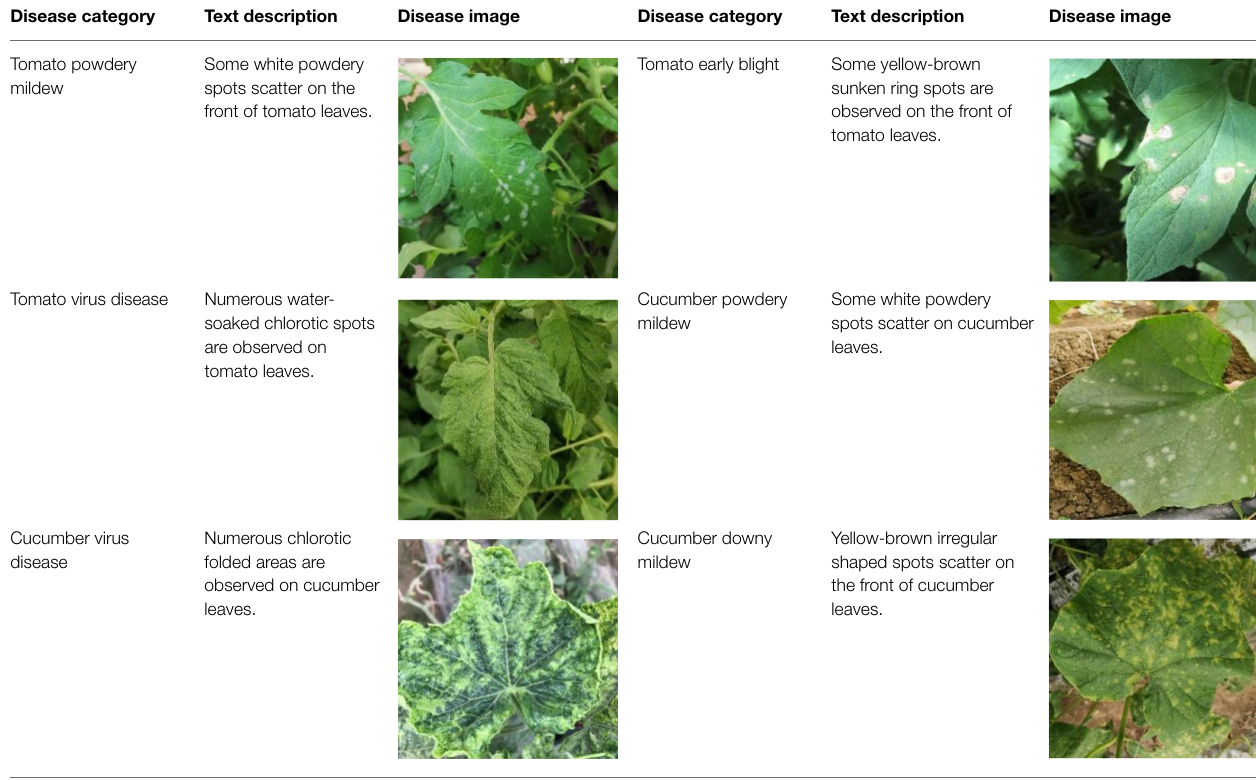
TABLE 2 | Examples of the image-text pair. Disease category